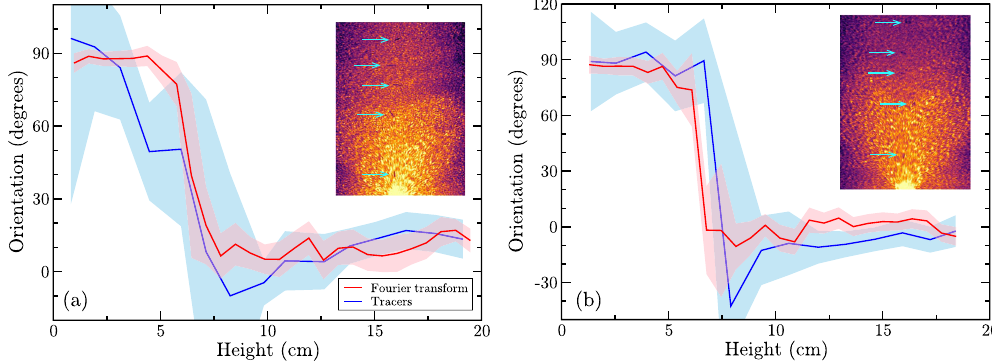
Figure 7. Comparison between orientation measured from tracers or by 2D Fourier transform of the density field for rice ( a ) or lentils ( b ). Shaded area are the 95% confidence interval on the estimated mean angle 69 . Insets: examples of radiographs of the silo flows with tracer particles being indicated by the blue